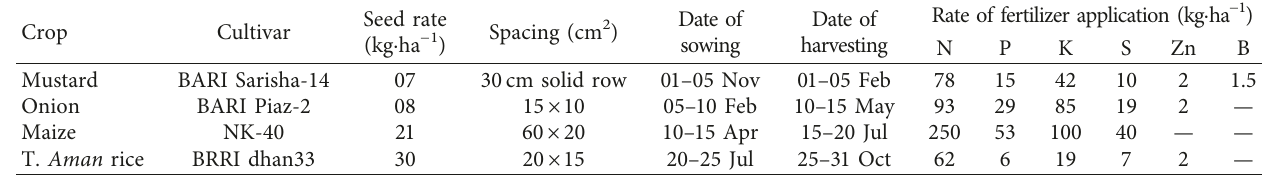
Table 1: Details of cultural practices adopted for different crops in field